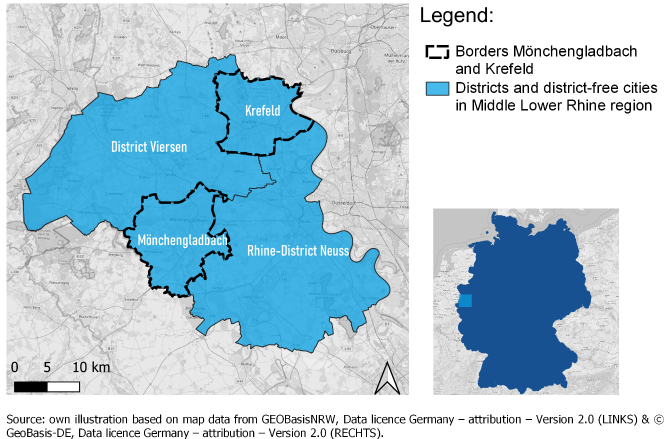
Figure 2: Map of the Middle Lower Rhine region in